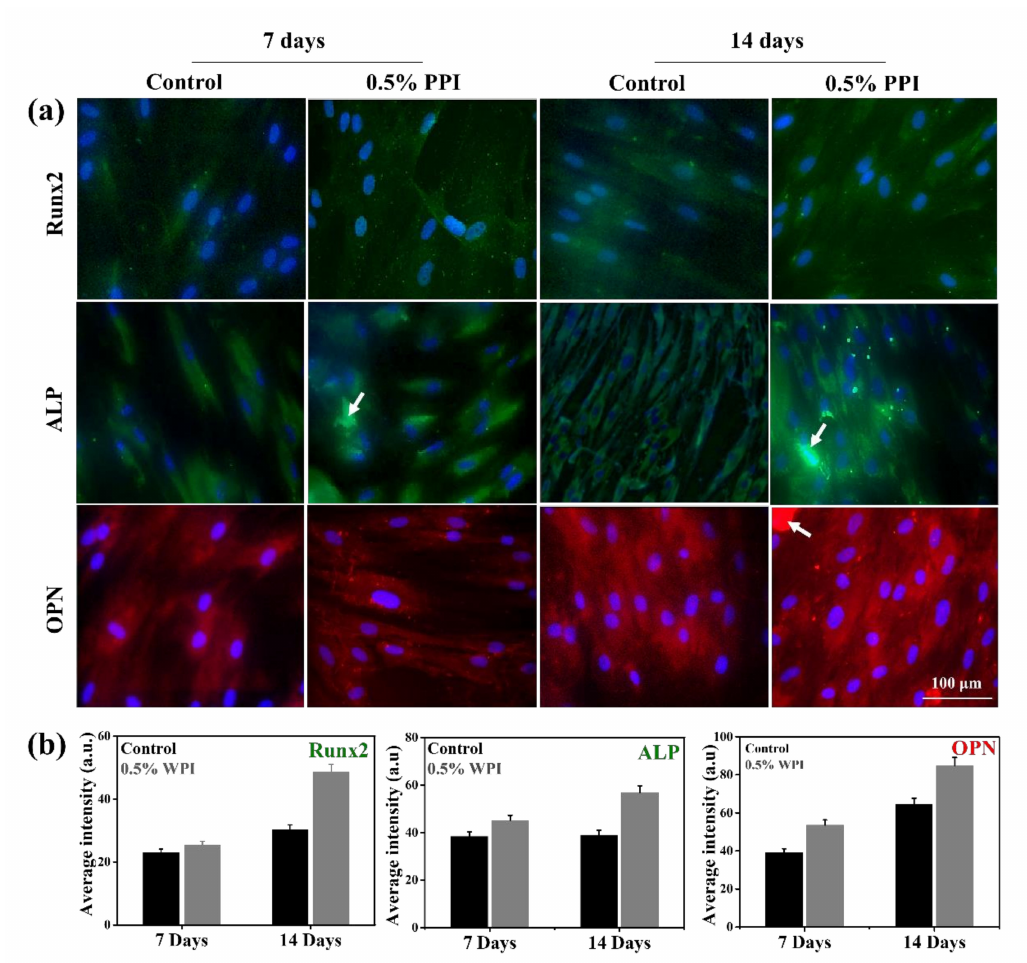
Figure 10. Osteoblast-specific protein markers’ expression of PPI-treated hBMSCs after seven and 14 days of treatment. ( a ) Fluorescence microscopy images of the respective protein markers (scale bar: 100 µ m), and ( b ) corresponding fluorescence intensities. The white arrow indicates the presence of PPI on the surface of hBMSCs.